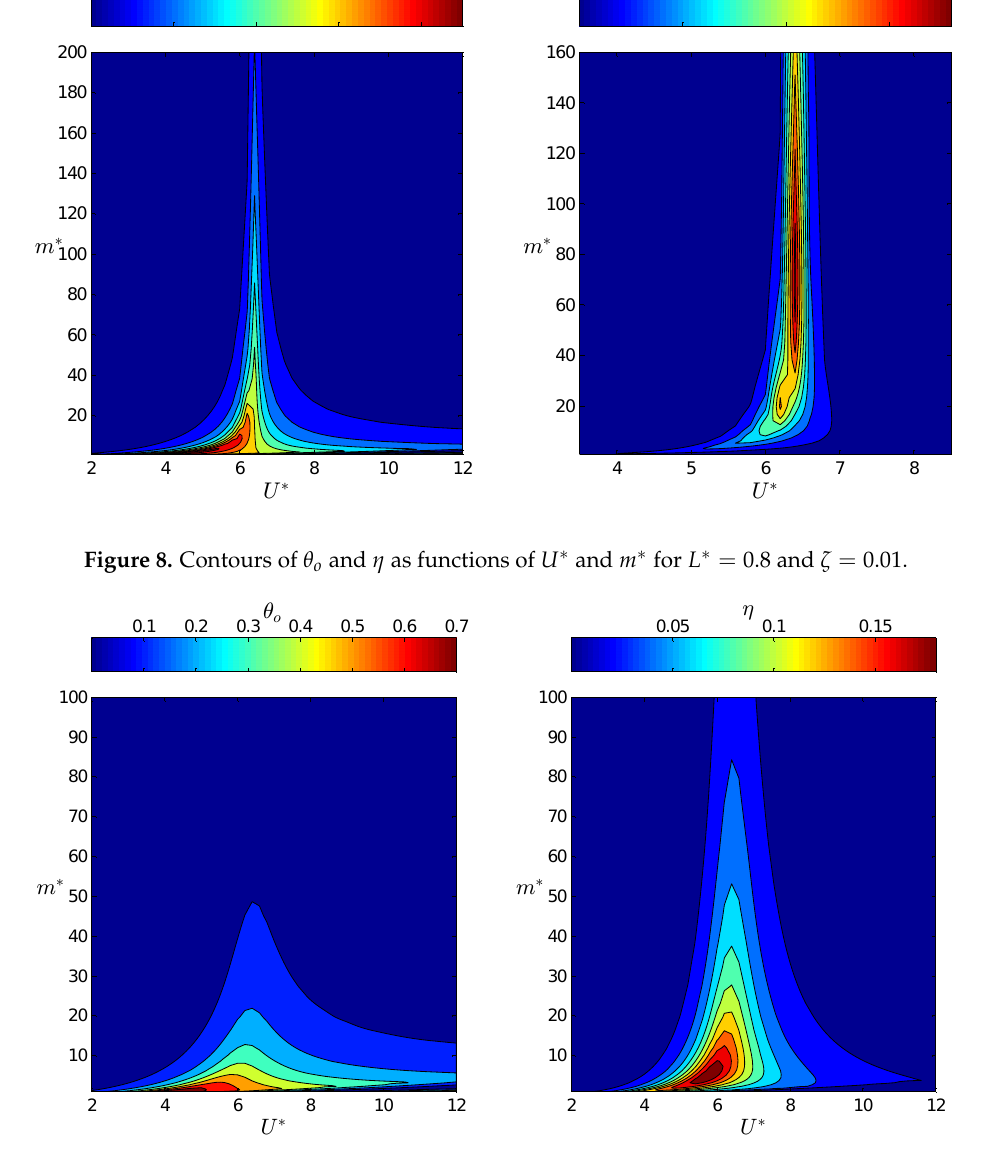
Figure 9. Contours of θ o and η as functions of U ∗ and m ∗ for L ∗ = 0.8 and ζ =